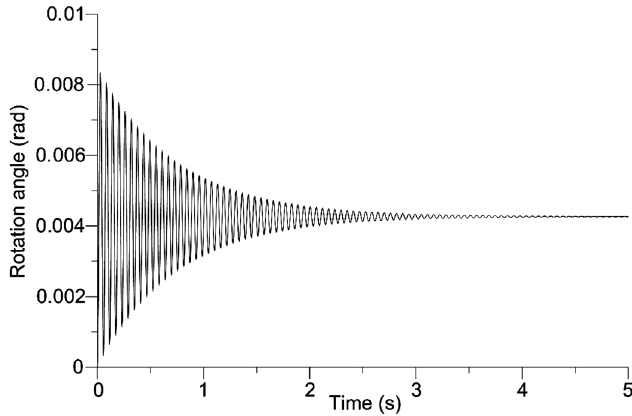
Figure 4. Instant rotation angle of the motion transmission left end in the first experiment.